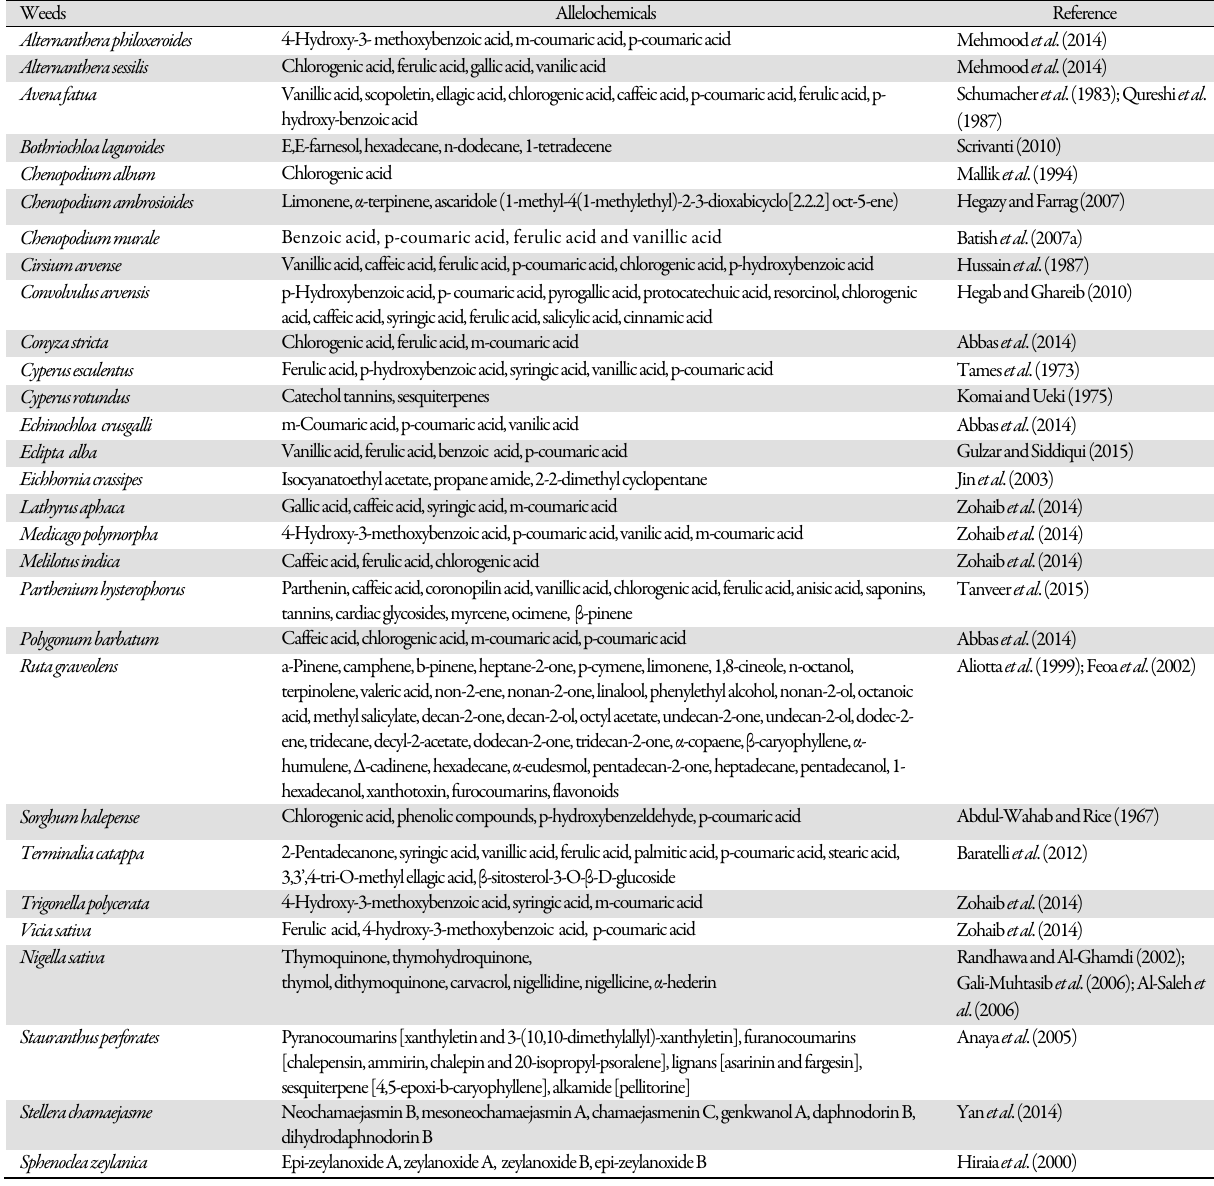
Table 1. Classic and novel candidates for allelochemicals found in some important weeds considered